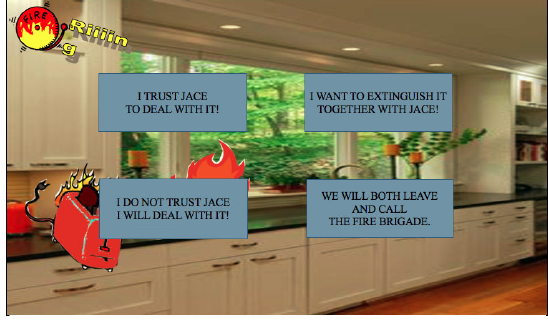
Figure 2: Emergency scenario: In the Figure a) a fire starts in the participant’s kitchen and the robot ask the participant to trust it to be able to deal with the emergency; in figure b) the participant’s level of trust in the robot is assessed through the listed choices.